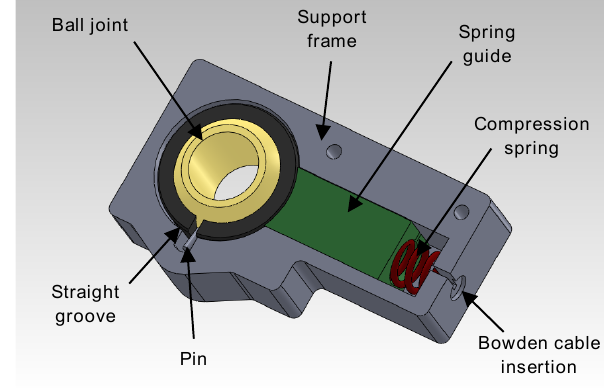
Figure 2. CAD view of the universal joint with locking compres- sion